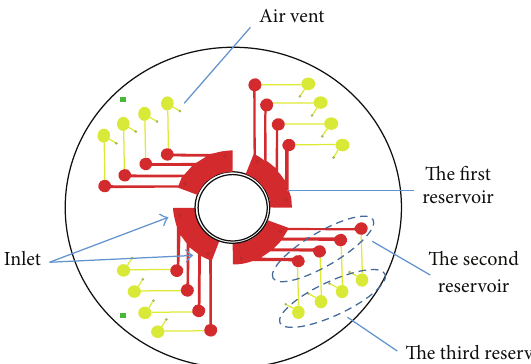
Figure 7: Illuminating PLED stage for turbidity